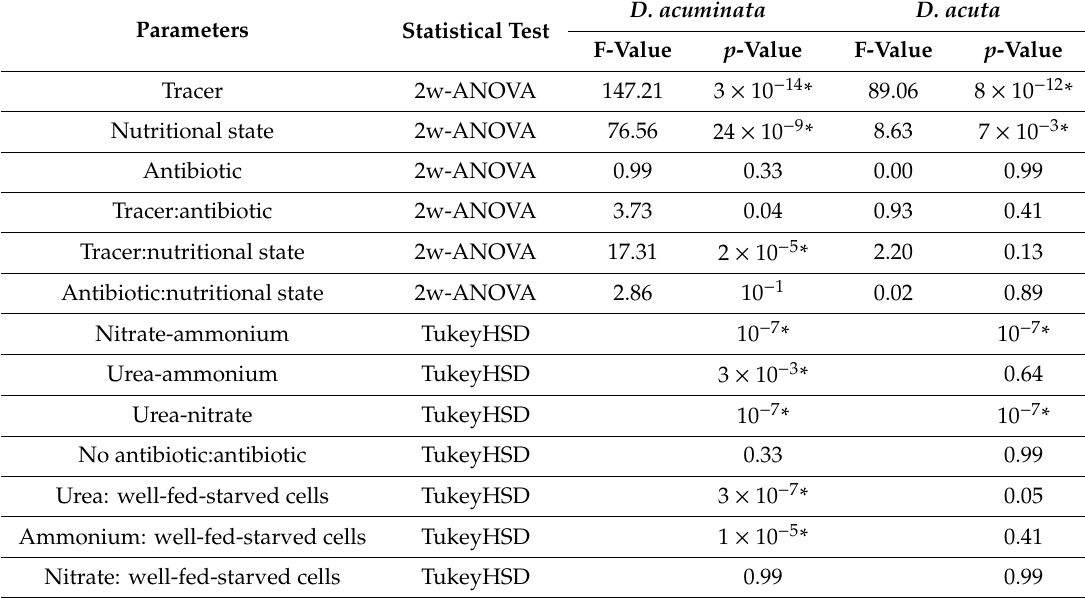
Table 2. Statistical significance of uptake rates of N sources by D. acuminata and D. acuta in well-fed and starved conditions, with and without antibiotics. 2w-ANOVA: two-way ANOVA. Asterisks (*) indicate high statistical